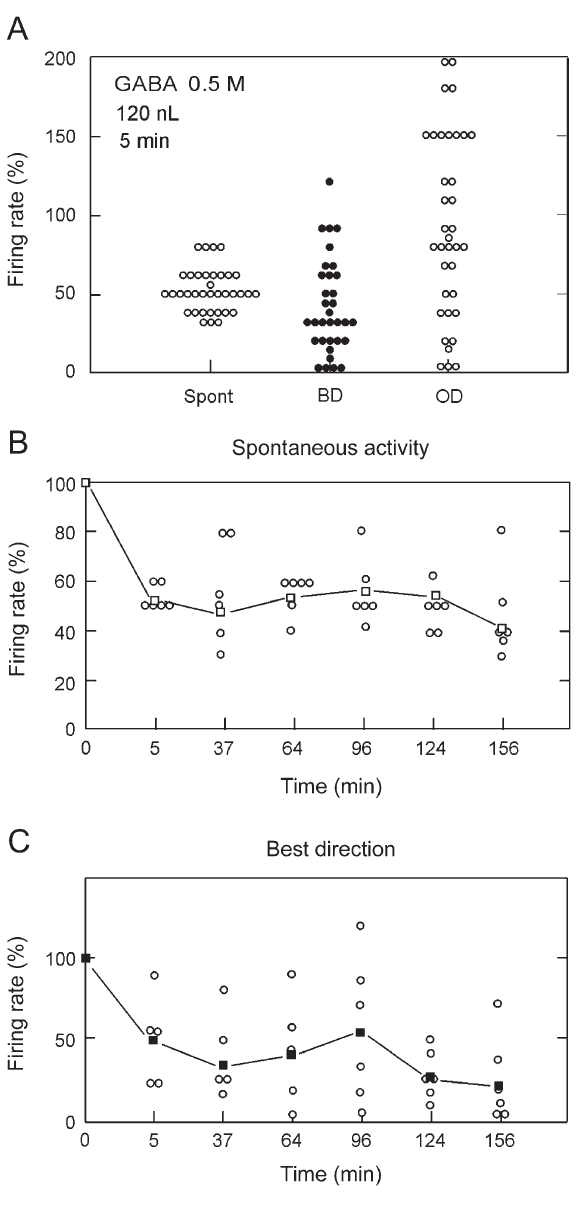
Figure 2. Strength and time course of the effect of a small GABA injection (120 nL, 0.5 M) on 6 neurons recorded in V2 during inactivation. A , Effect of GABA inactivation on the electrical activity of neurons shown as a percentage, normalized relative to control neurons for the spontaneous activity of neurons (Spont), best direction (BD) and other direction (OD). B , Time course of the effect of GABA inactivation on spontaneous activity and C , on the best direction of neurons over a period of 156 min. Open circles are normalized percentage of firing rate of the spontaneous activity ( B ) and of the best response ( C ) of each of the six neurons. Squares are the mean of normalized firing rate of the spontaneous activity ( B ) and the response to the best direction ( C